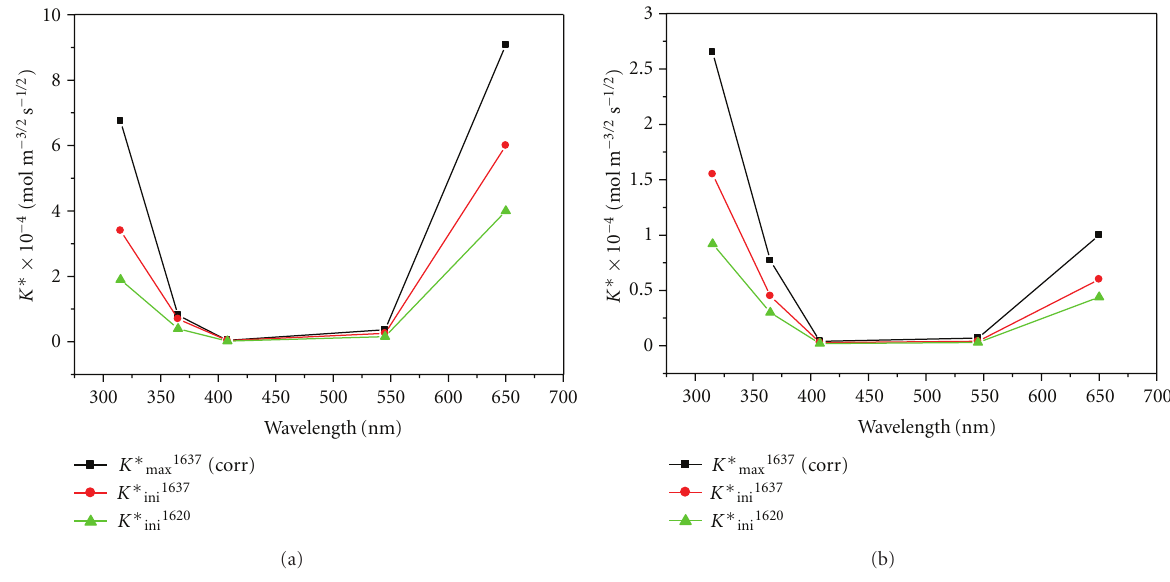
Figure 4: The influence of the wavelength of illumination on the K ∗ values for starting MPS-Sb:SnO 2 /PEGDA formulations against the wavelength of radiation λ (nm). (a) Sb = 0%; (b) Sb = 7%.